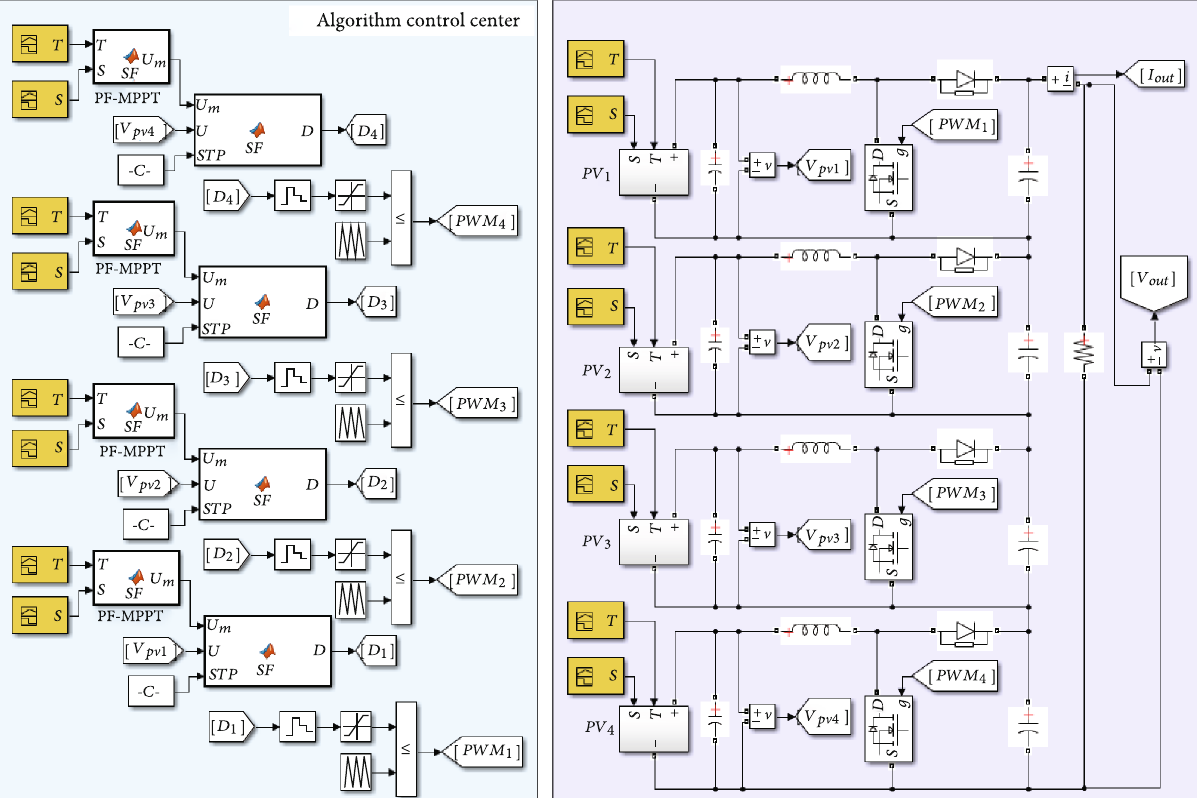
Figure 17: Improved MPPT